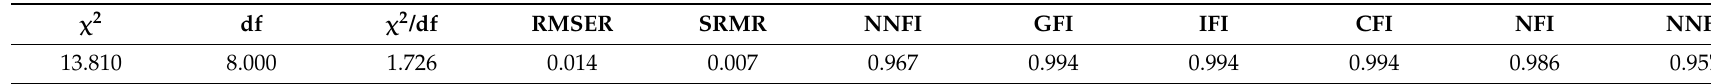
Table 4. Fitting indices for default model.